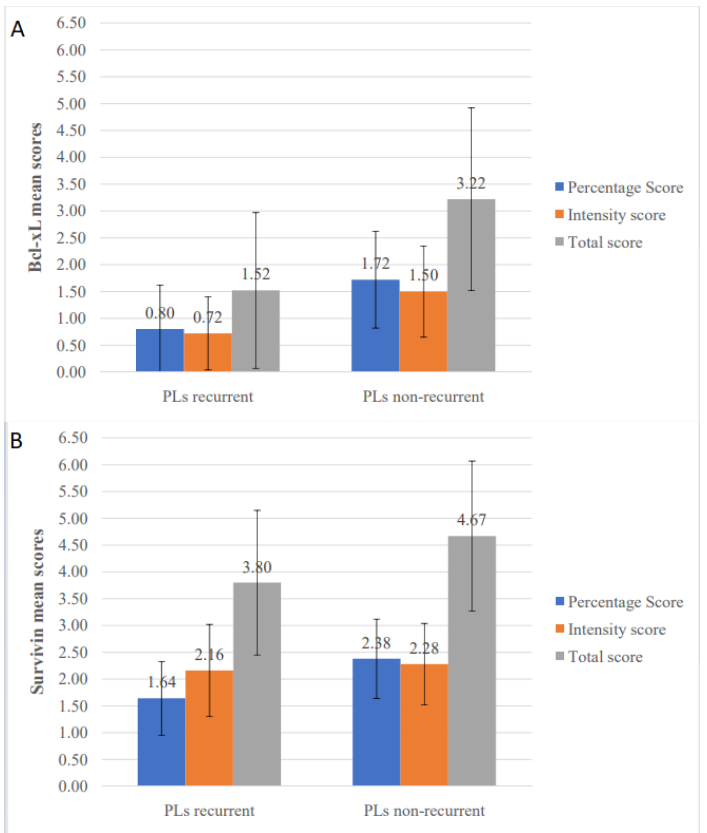
Figure 5. Comparison of immunohistochemical mean scores between recurrent and non-recurrent primary oral leukoplakia lesions (PLs). ( A ) Bcl-xL percentage, intensity and total scores and ( B ) survivin percentage, intensity and total scores.